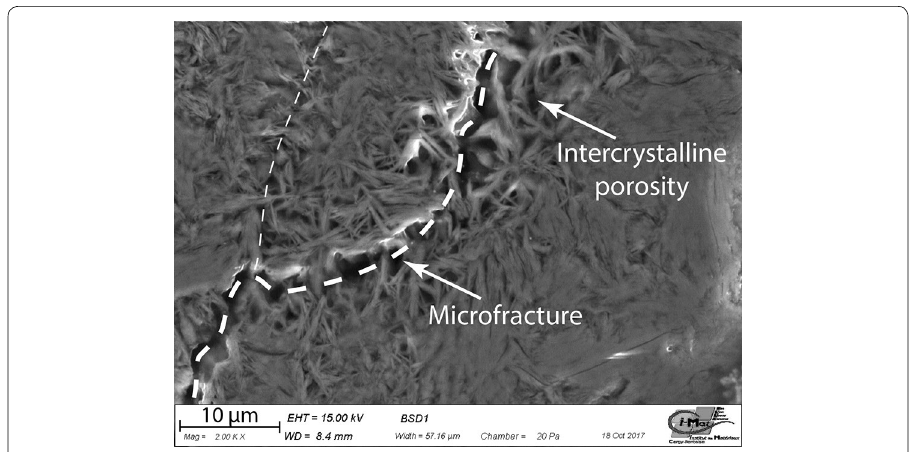
Fig. 5 Scanning Electron Microscopy (SEM) image of a small zone of altered sample 15.142 showing a total replacement of primary volcanic minerals and groundmass by K-phyllosilicates. Crystallization of K-phyllosilicates is posterior to the development of microfractures as they partially bond them. Intercrystalline porosity is also encountered between K-phyllosilicate crystallites